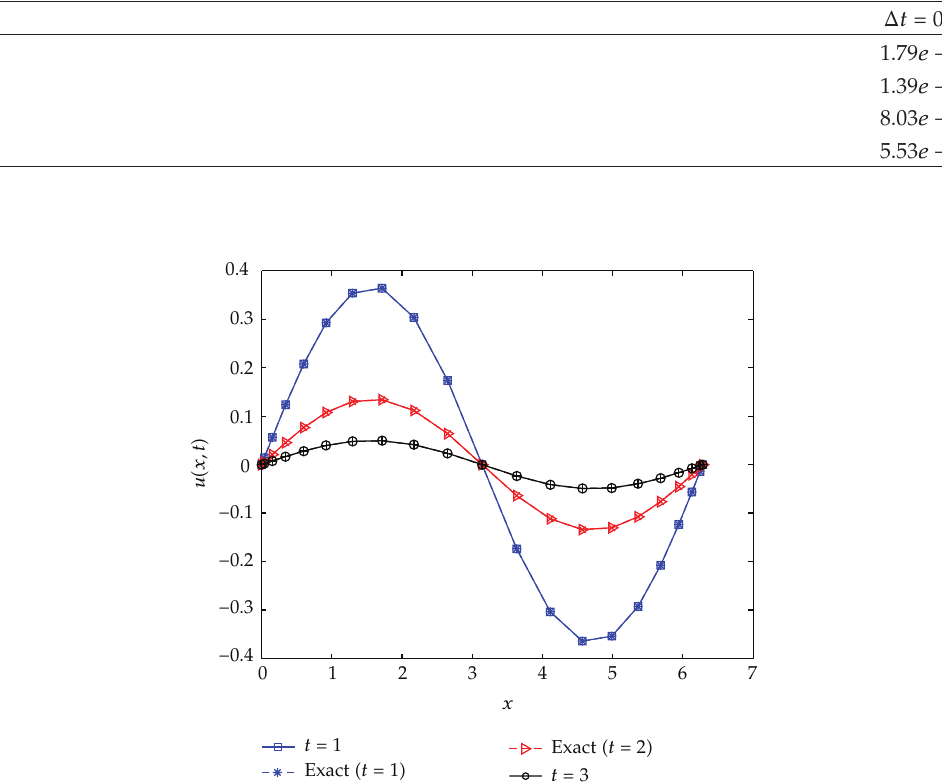
Table 3: RMS errors for Problem 1 with N (cid:6) 11 using FDQ with Neumann boundary conditions.